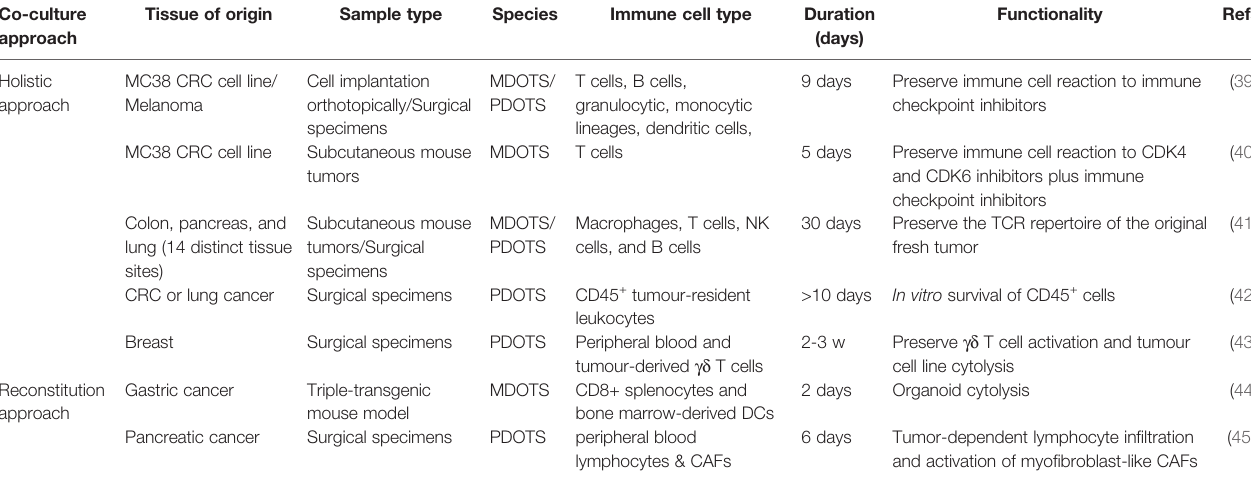
TABLE 1 | Overview of currently established tumor organoid-immune cell co-culture systems. Co-culture